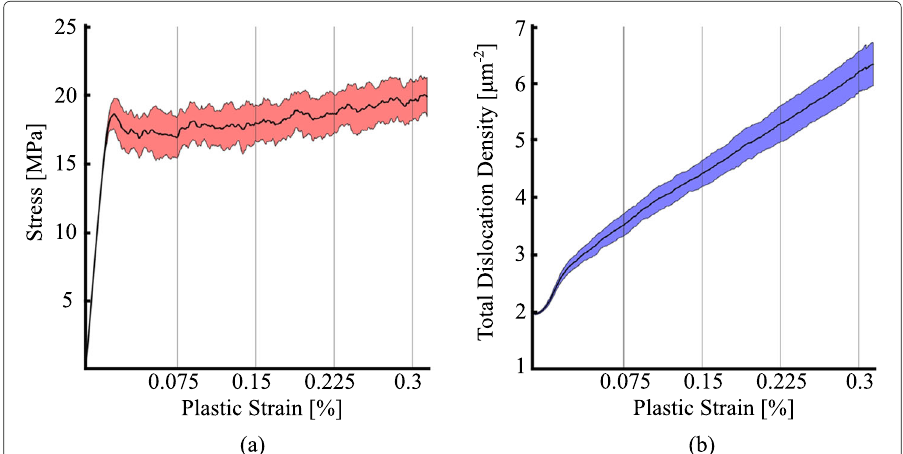
Fig. 2 Representative simulation results from discrete dislocation dynamics. The representative stress-strain behavior of the 45 simulations is shown in ( a ), while the representative total dislocation density evolution is shown in ( b ). Both are plotted with respect to the total strain, while the plastic strain values where dislocation configurations were extracted are shown. Both show the mean behavior at each timestep of the 45 simulations in black, while the shaded region represents one standard deviation away from the mean. a shows little strain hardening in the simulated regime. b shows a linear increase in the total dislocation density, roughly doubling across the regions of plastic strain we